Question: State the chart type depicted above.
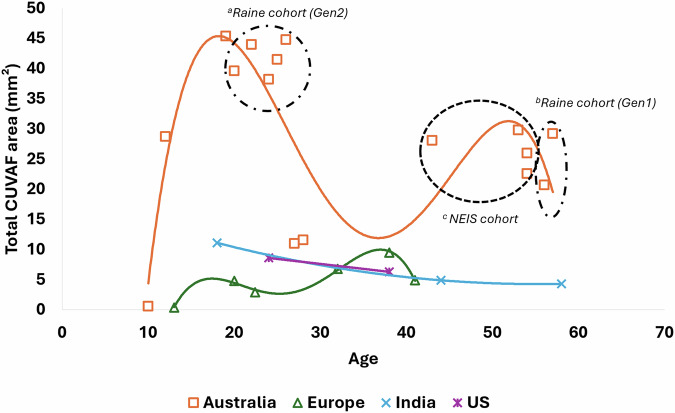
Answer: line